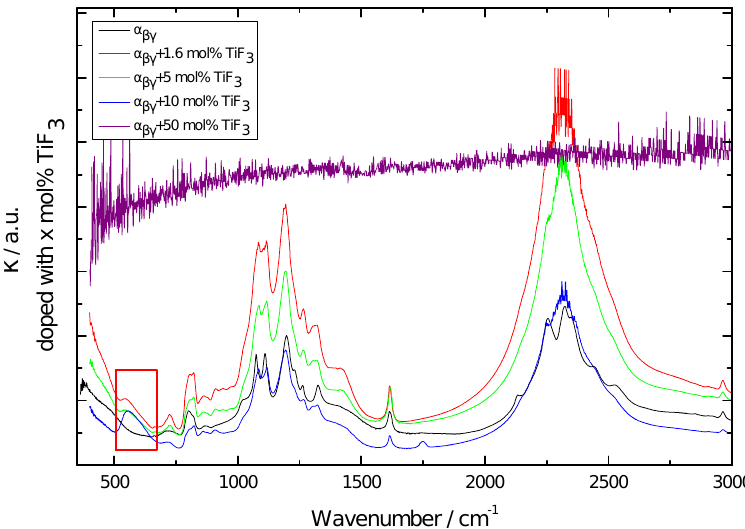
Figure 3. Infrared (IR) spectra for α βγ -Ca(BH 4 ) 2 samples with additive. External modes corresponding to lattice vibrations in TiF 3 are marked with a red box. The spectrum of a sample prepared by milling α βγ + 50 mol% TiF 3 is also included.